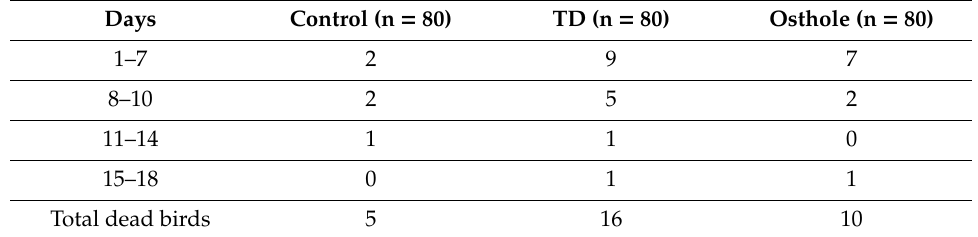
Table 2. Mortality Table 2. Mortality rates.